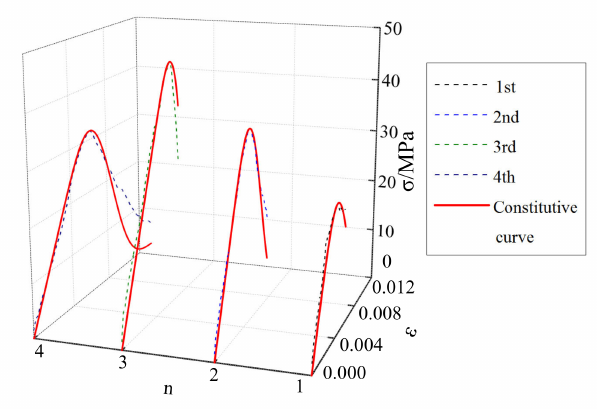
Figure 14. Comparison between the 0.175 MPa-pressure cyclic-impact test results and the theoretical results for mudstone.